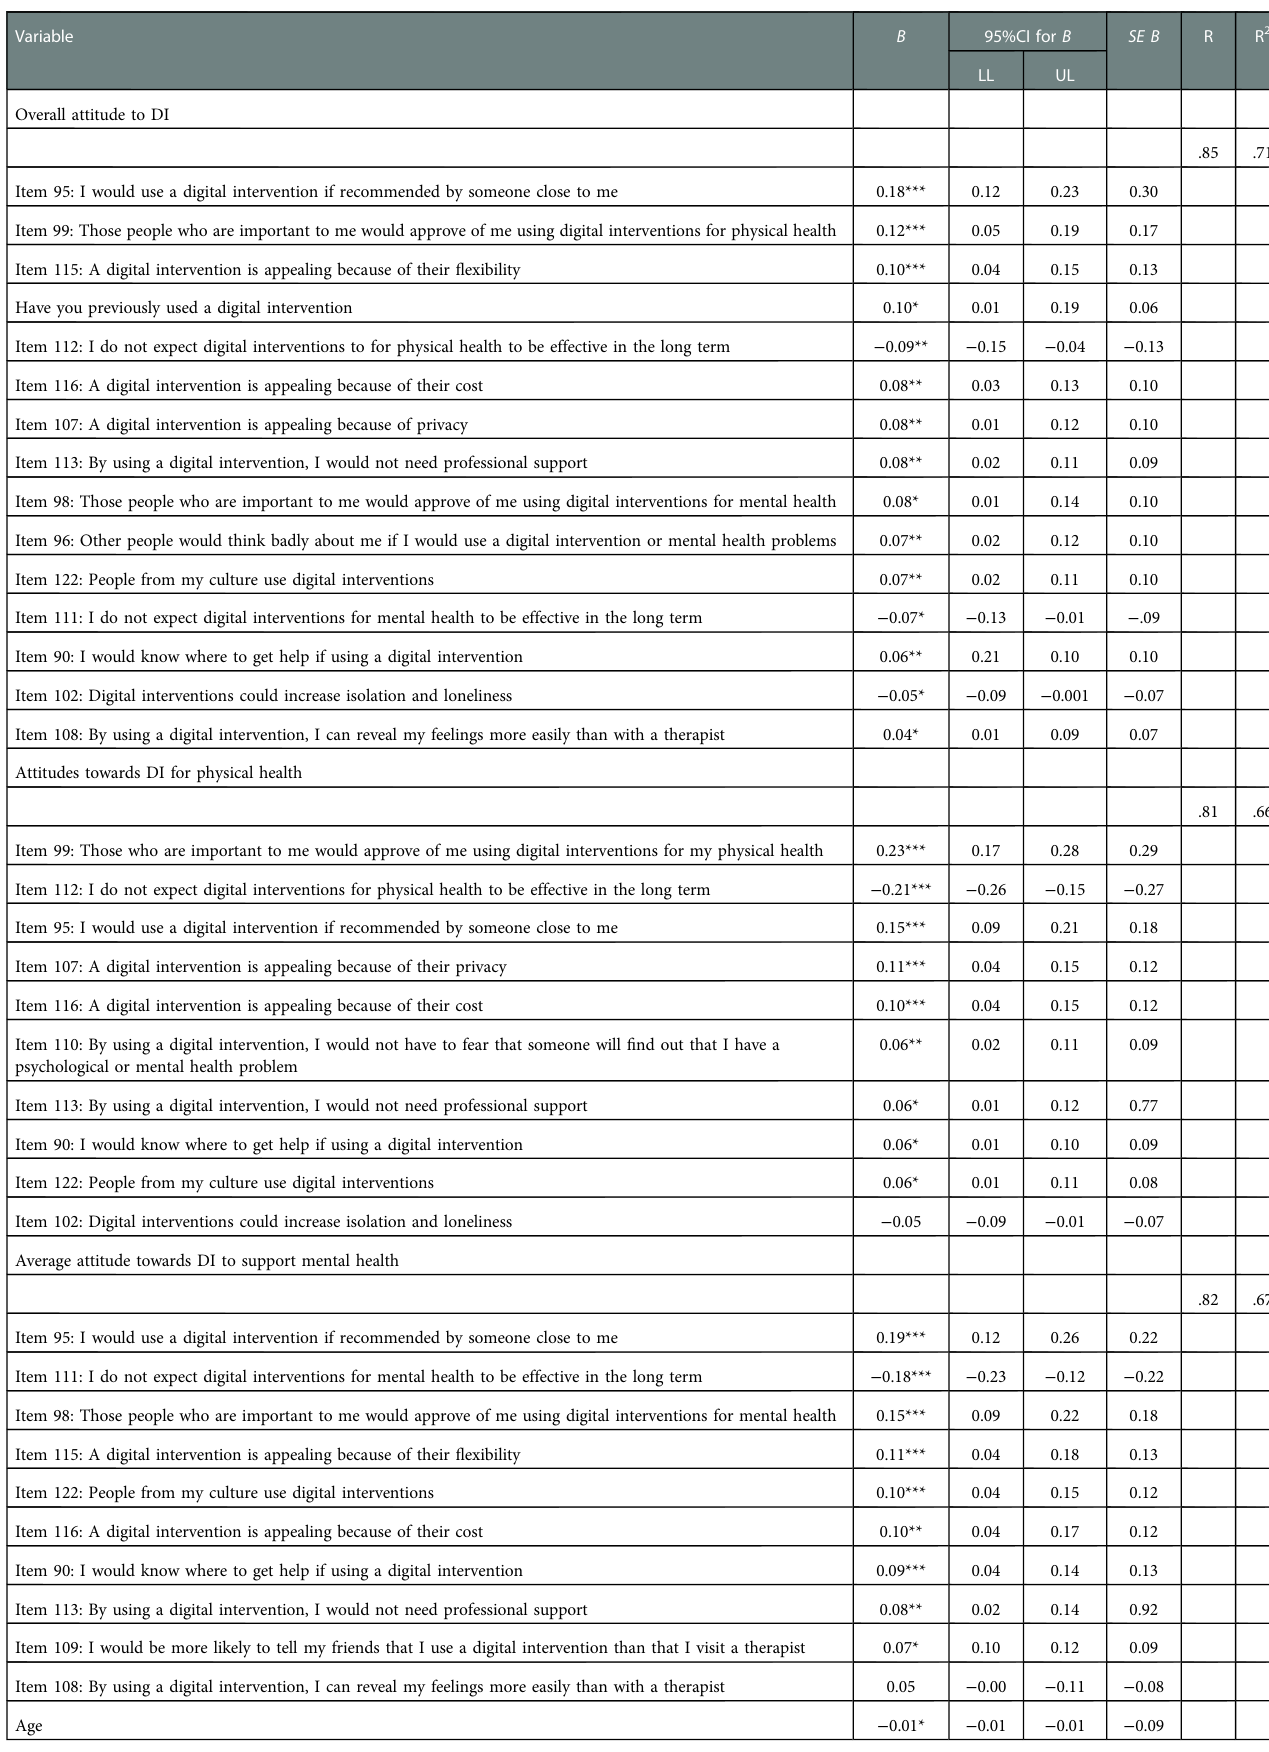
TABLE 6 Stepwise regression of overall attitude to DI, DI for physical health (PH) and for mental health (MH). Variable